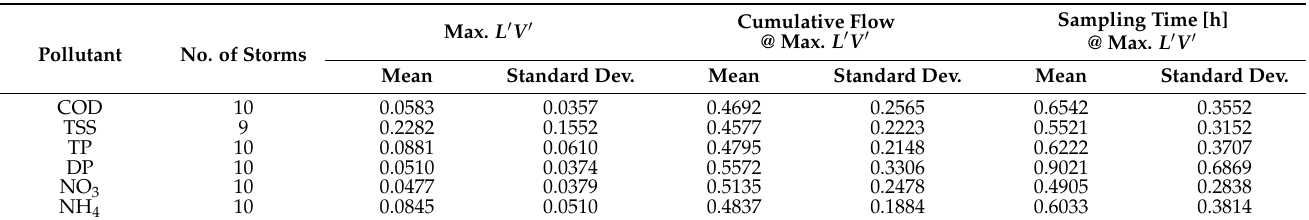
Table 5. Method 1 results summary.